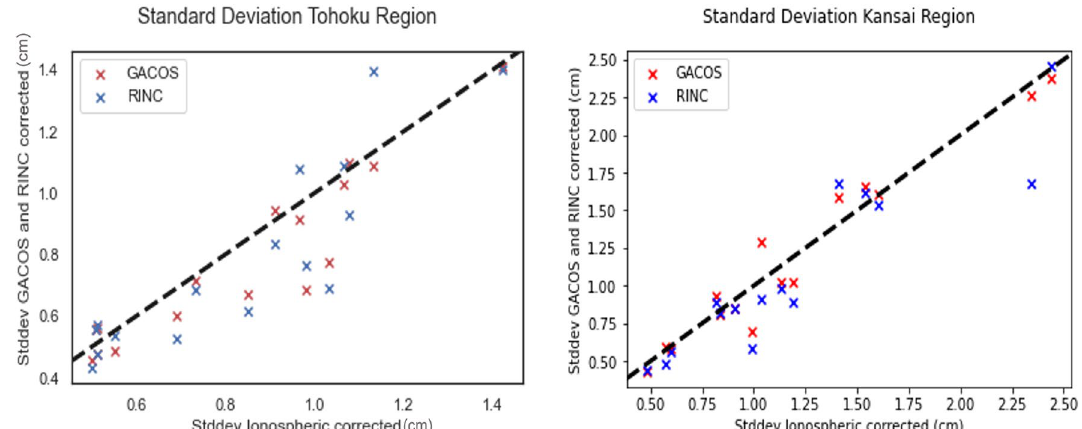
Fig. 9 Standard deviations after tropospheric corrections using RINC and GACOS in the two study areas plotted against the standard deviations before the tropospheric corrections (reference). Marks below the broken line (standard deviations before and after correction are equal) indicate